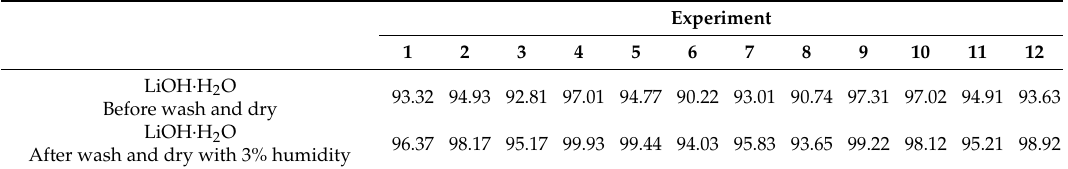
Table 4. Solid product chemical analysis for all experiments, in wt%.